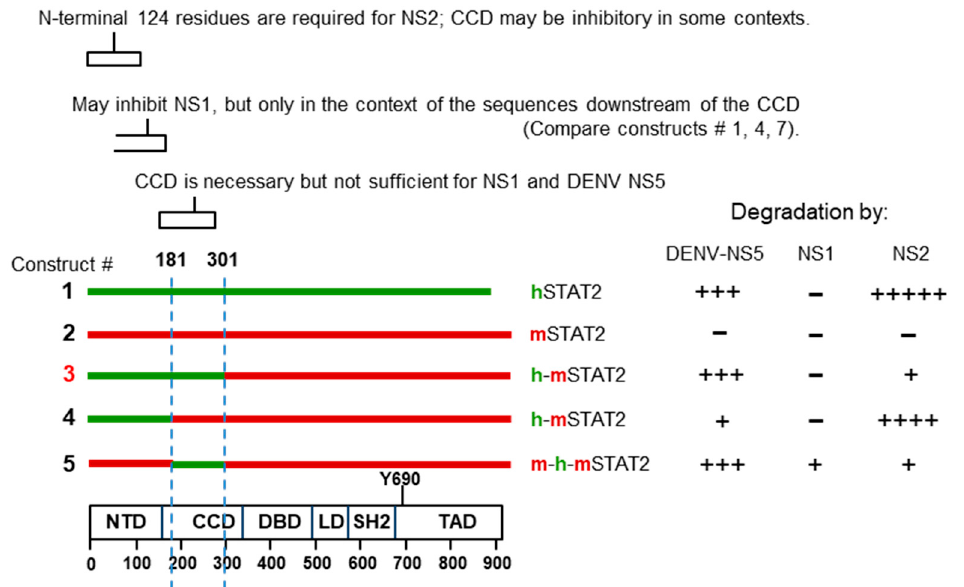
Figure 8. Distinctive actions of the two RSV NS proteins on human STAT2 (hSTAT2), mouse STAT2 (mSTAT2), and their chimera are compared with the activities of dengue virus NS5 protein on the same constructs [77]. Human sequences are colored green, and mouse sequences are red. The known motifs of STAT2 are marked in the schematic at the bottom, drawn to approximate scale by amino acid numbers. The roles of key sequence regions of the STAT constructs in NS1/2 and NS5 degradative functions are briefly described on the top. The degradative activity of equal amounts of the expressed proteins are qualitatively indicated by + and − signs; for example, NS2 is highly active on hSTAT2, but does not degrade mSTAT2 at all. See Section 2.3.3, article 2 for the